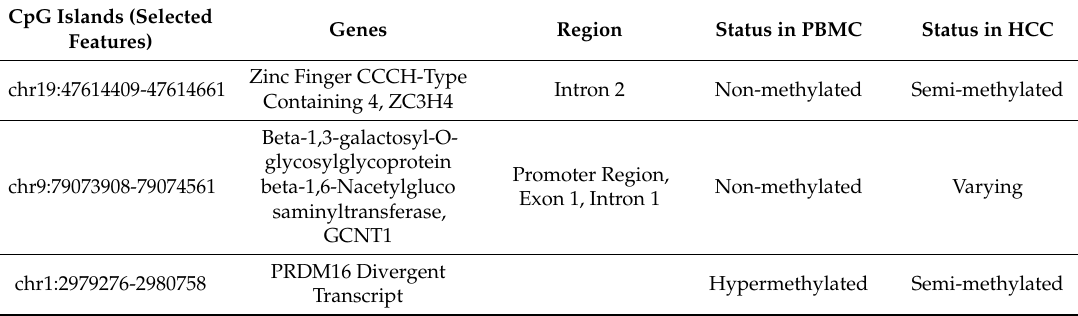
Figure 2. cfDNA classification based on random forest trained with 60% of complete data. ( a ) Average prediction accuracy of the random forests trained with—and tuned on—the features selected by the indicated methods. ( b ) Average F1 score of the same predictions. The y -axis indicated the score. Black bars are the standard deviation. The selectors were given the complete set of data as a randomly split training and test set with test sizes of 0.4. Ten iterations were conducted with di ff erent random states. CpG islands methylation (blue) or CpG sites (orange) were used for the analysis. Table 2. Frequently recurring features occurring in all feature selections and in multiple random states resulting in a high accuracy of